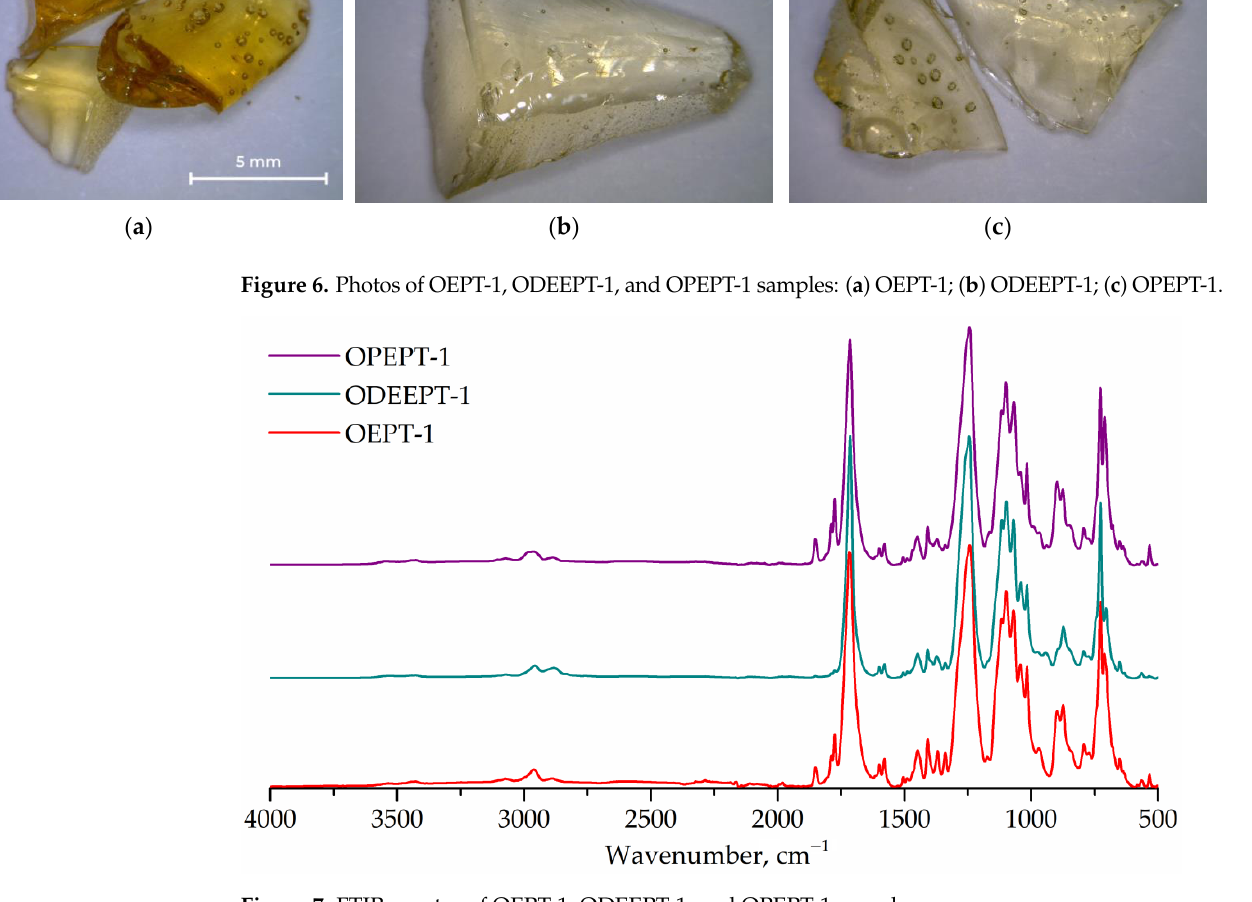
Table 4. Characteristics of OEPT-1, ODEEPT-1, and OPEPT-1 samples: number average (Mn)